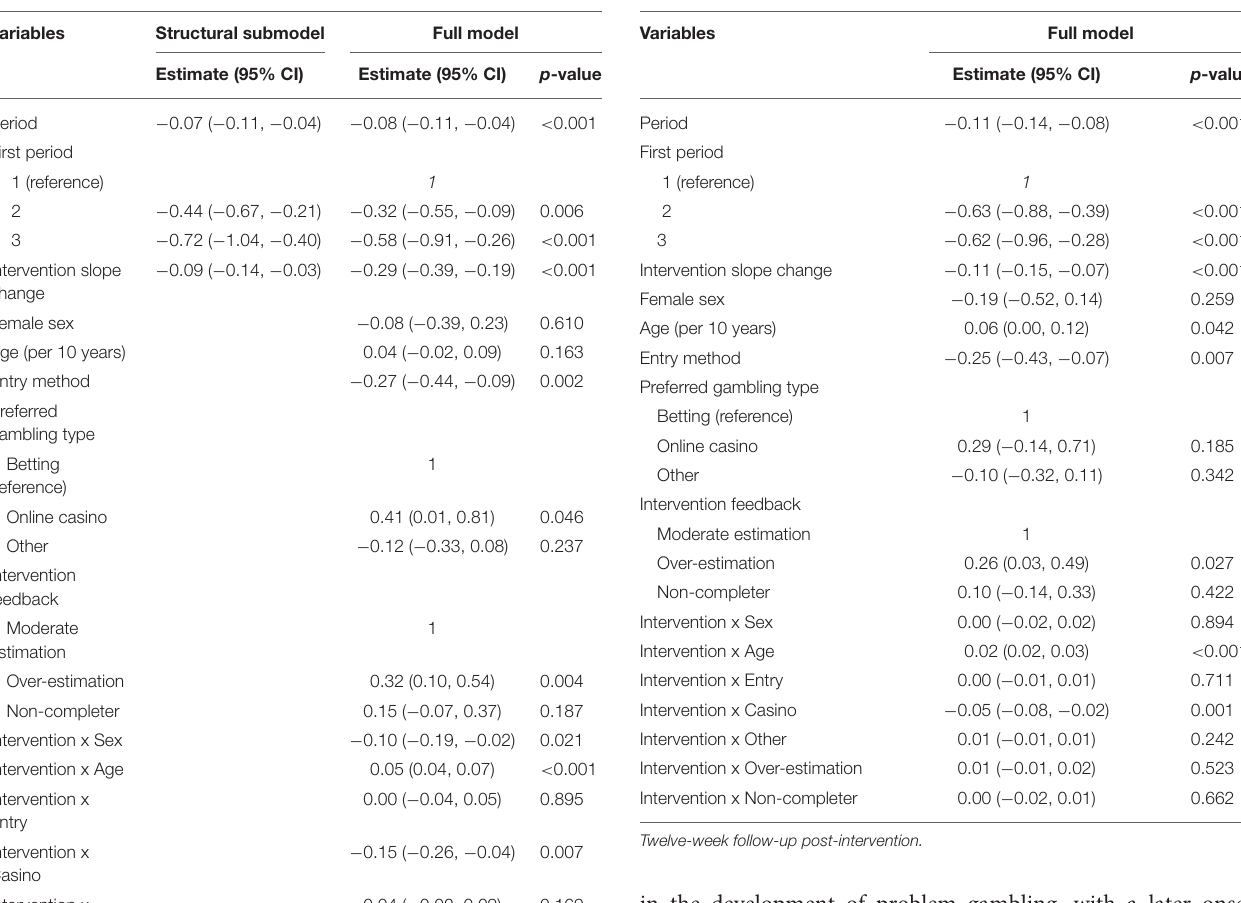
TABLE 1 | Mixed model regression models on log ADW as dependent variable. TABLE 2 | Mixed model regression models on log ADW as dependent